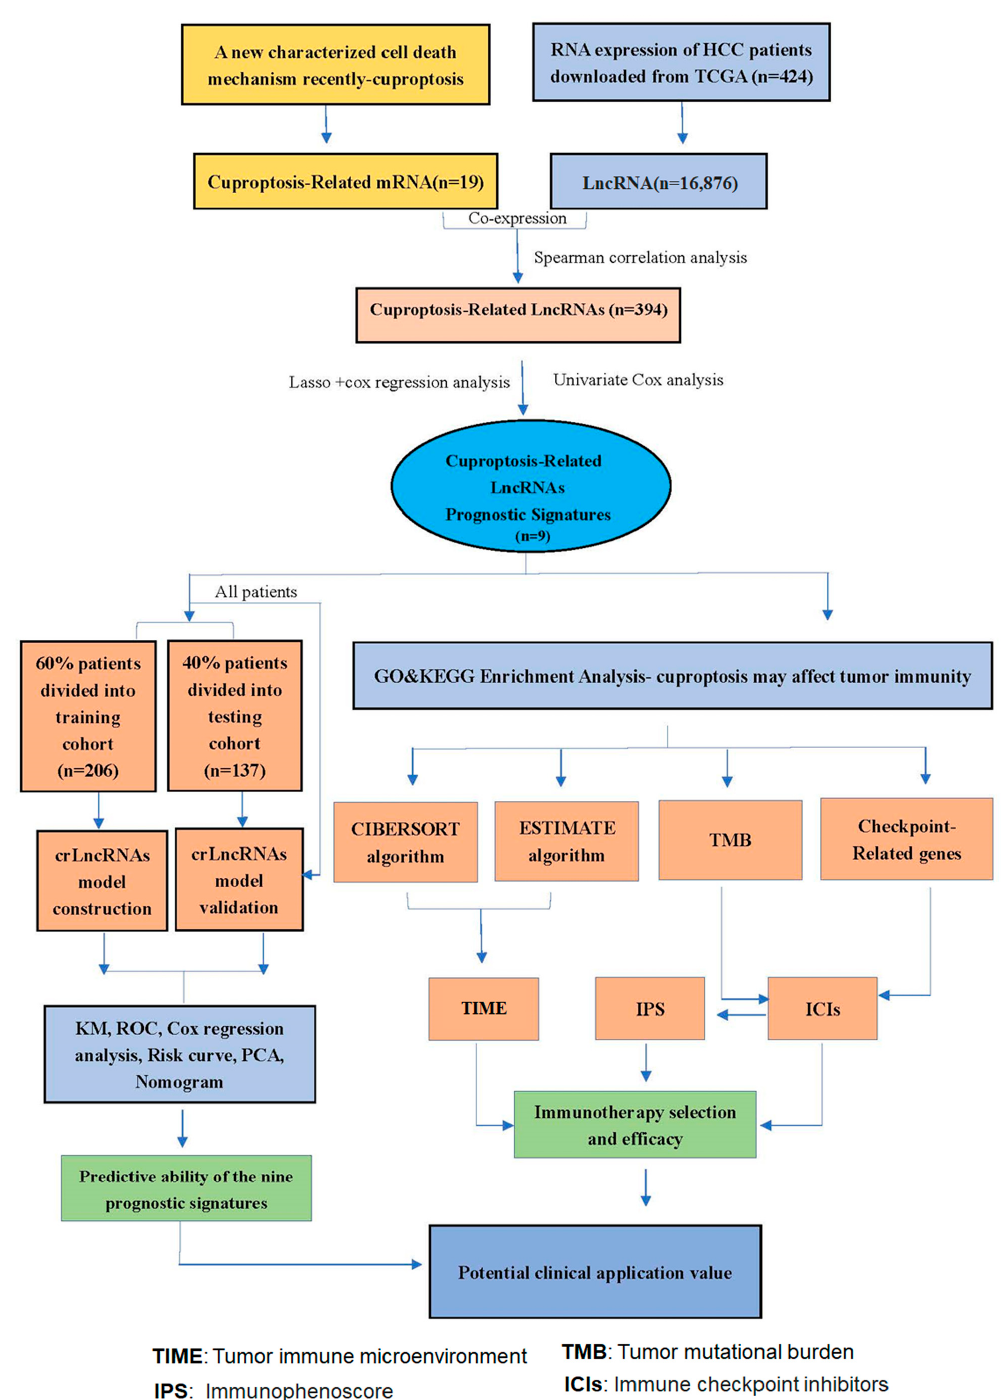
Figure 1. Flow chart of this study. A total of 343 HCC patients with complete survival information in the TCGA database were divided into two cohorts, i.e., training and testing. Using the expression data of 147 prognostic crLncRNA genes in the training cohort, the 9-crLncRNA signatures based on LASSO and COX regression analyses were obtained, and the optimal penalty parameter ( λ ) of the LASSO model was constructed. The KM curves, ROC curves, PCA analysis, DCA curves, and nomogram were applied to evaluate the accuracy and reliability of the 9-crLncRNA prognostic model. Subsequently, a series of analyses, including ssGSEA, KEGG, GO, GSVA, immune-related, immunecheckpoint-related genes, somatic mutations, and drug sensitivity analyses, were applied to explore the potential of classifying the population as sensitive to treatment and its